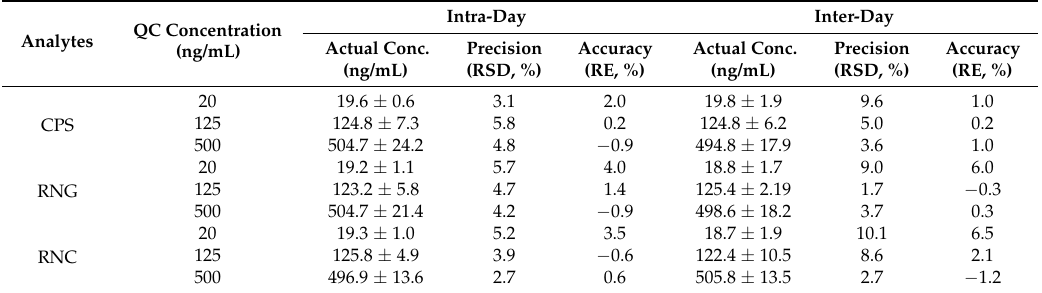
Table 5. Intra-day and inter-day precision and accuracy of CPS, RNG, and RNC in rat plasma ( n = 6).